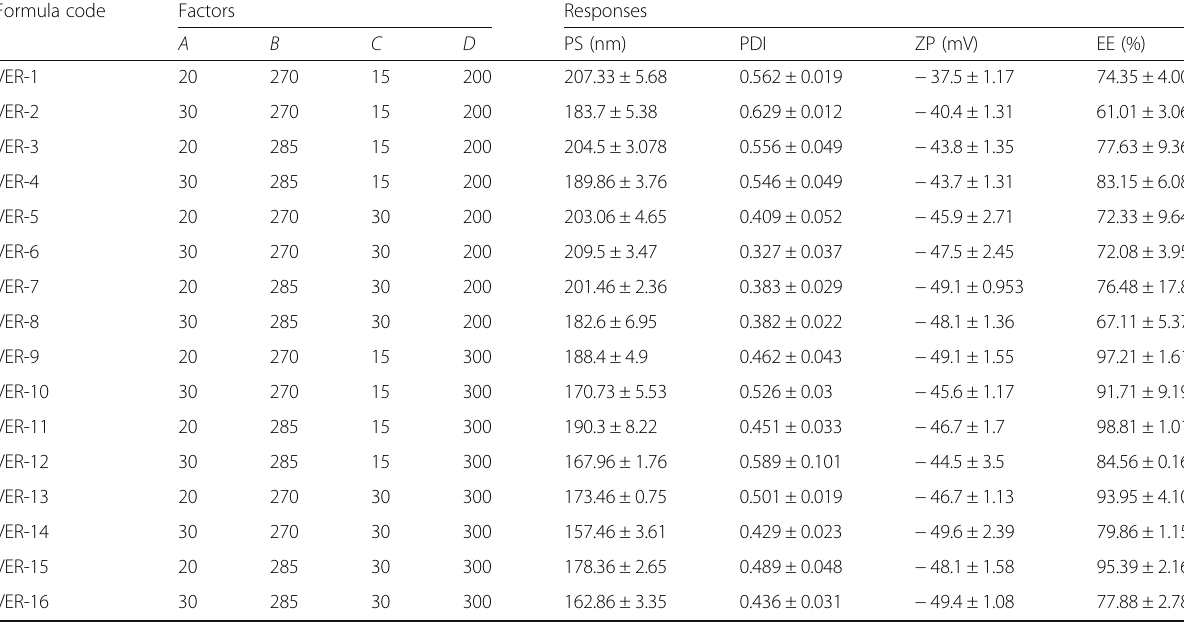
Table 2 Observed responses (mean) in 2 4 full factorial design for HVD-NLCs Formula